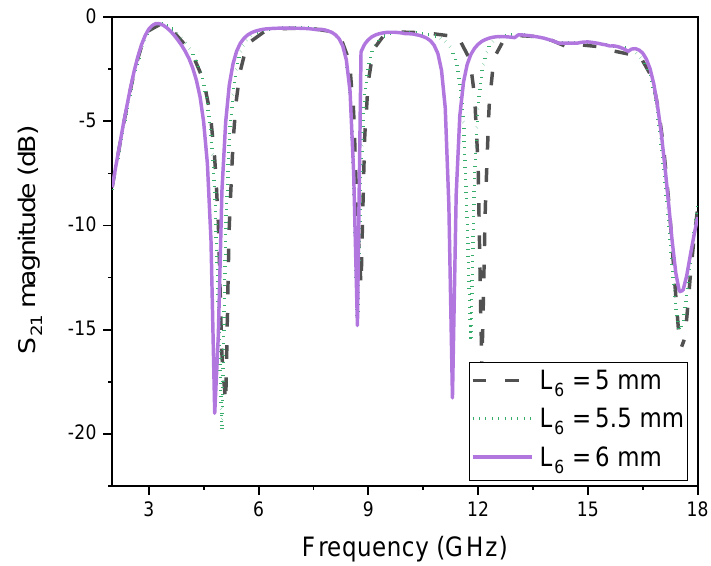
Figure 15. Validation of third band control w.r.t L 5.